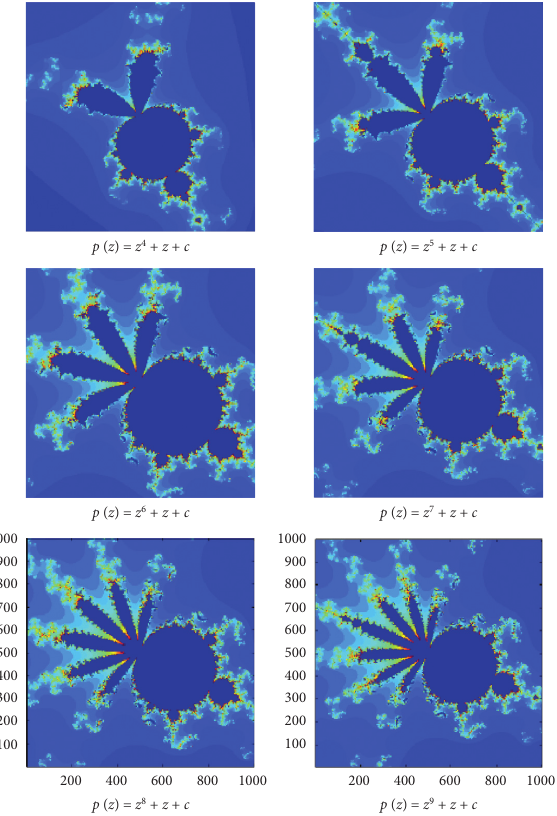
Figure 14: The general Mandelbrot set for P